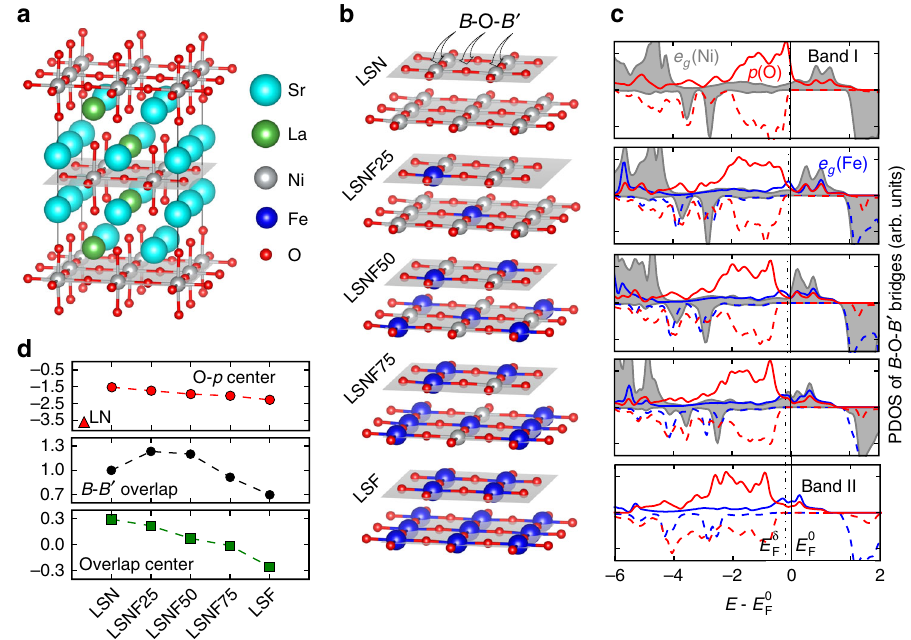
Fig. 5 Density functional theory modeling of atomic and electronic structures of bulk LSNF in ferromagnetic con fi guration. a The ground state 2 × 2 × 1 cell of La 0.5 Sr 1.5 NiO 4 , with uniformly distributed La in each [001] A O layer. b Representations of the two B ( B ′ )O 2 layers for each ground state La 0.5 Sr 1.5 Ni 1 − x Fe x O 4 , with x at 0, 0.25, 0.5, 0.75, and 1; for each x , the ground state Fe arrangement is characterized by equal numbers of Fe in the two B ( B ′ ) O 2 layers, with the Fe in each layer arranged to maximize the number of Fe – O – Ni bridges. c The corresponding spin polarized PDOS of e g (Ni: gray shaded area and Fe: blue line) and 2 p (O: red line) with respect to Fermi level ( E 0 ) for the B – O – B ′ bridges; the PDOS are the average of existing B – O – B ′ bridges; the F ¼ E 0 (cid:2) 2 e (cid:2) δ = DOS ð E 0 Þ (Eq. (1)), where DOS ð E 0 Þ is adapted Fermi level ( E δ ) to oxygen hyperstoichiometry is estimated via the rigid band model, with E δ F F F F F the total density of states at E 0 per formula unit of LSNF. d Top: Computed values of the O – p band center (top panel), with La 2 NiO 4 calculated as reference. F Middle: The magnitude of band overlap, determined by the integration of maximum PDOS between e g ( B ) and e g ( B ′ ) from − 2 to 2 eV, normalized to e g (Ni) in LSN. Bottom: The corresponding overlap center (centroid) of maximum PDOS between e g ( B ) and e g ( B ′ ). Additional details can be found